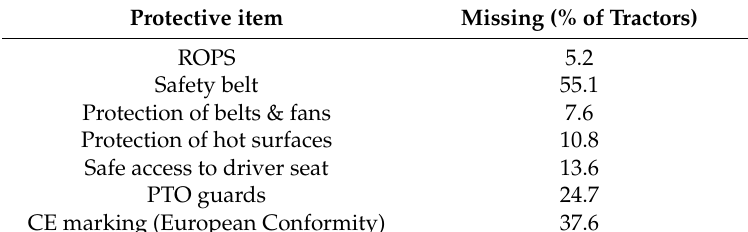
Table 6. Protective devices.